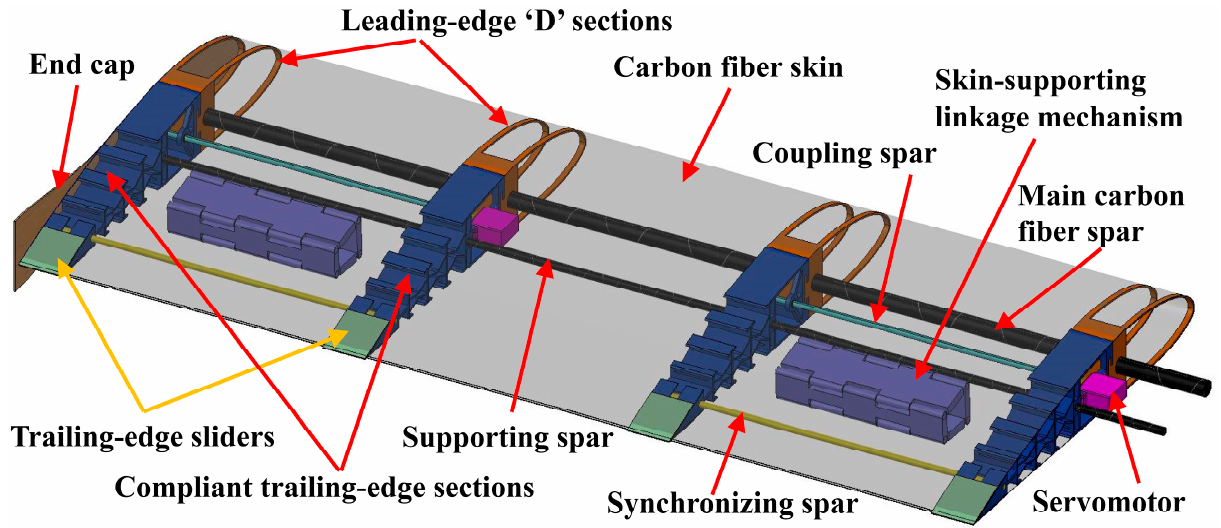
Figure 7. CAD model of the MM-3 wing.